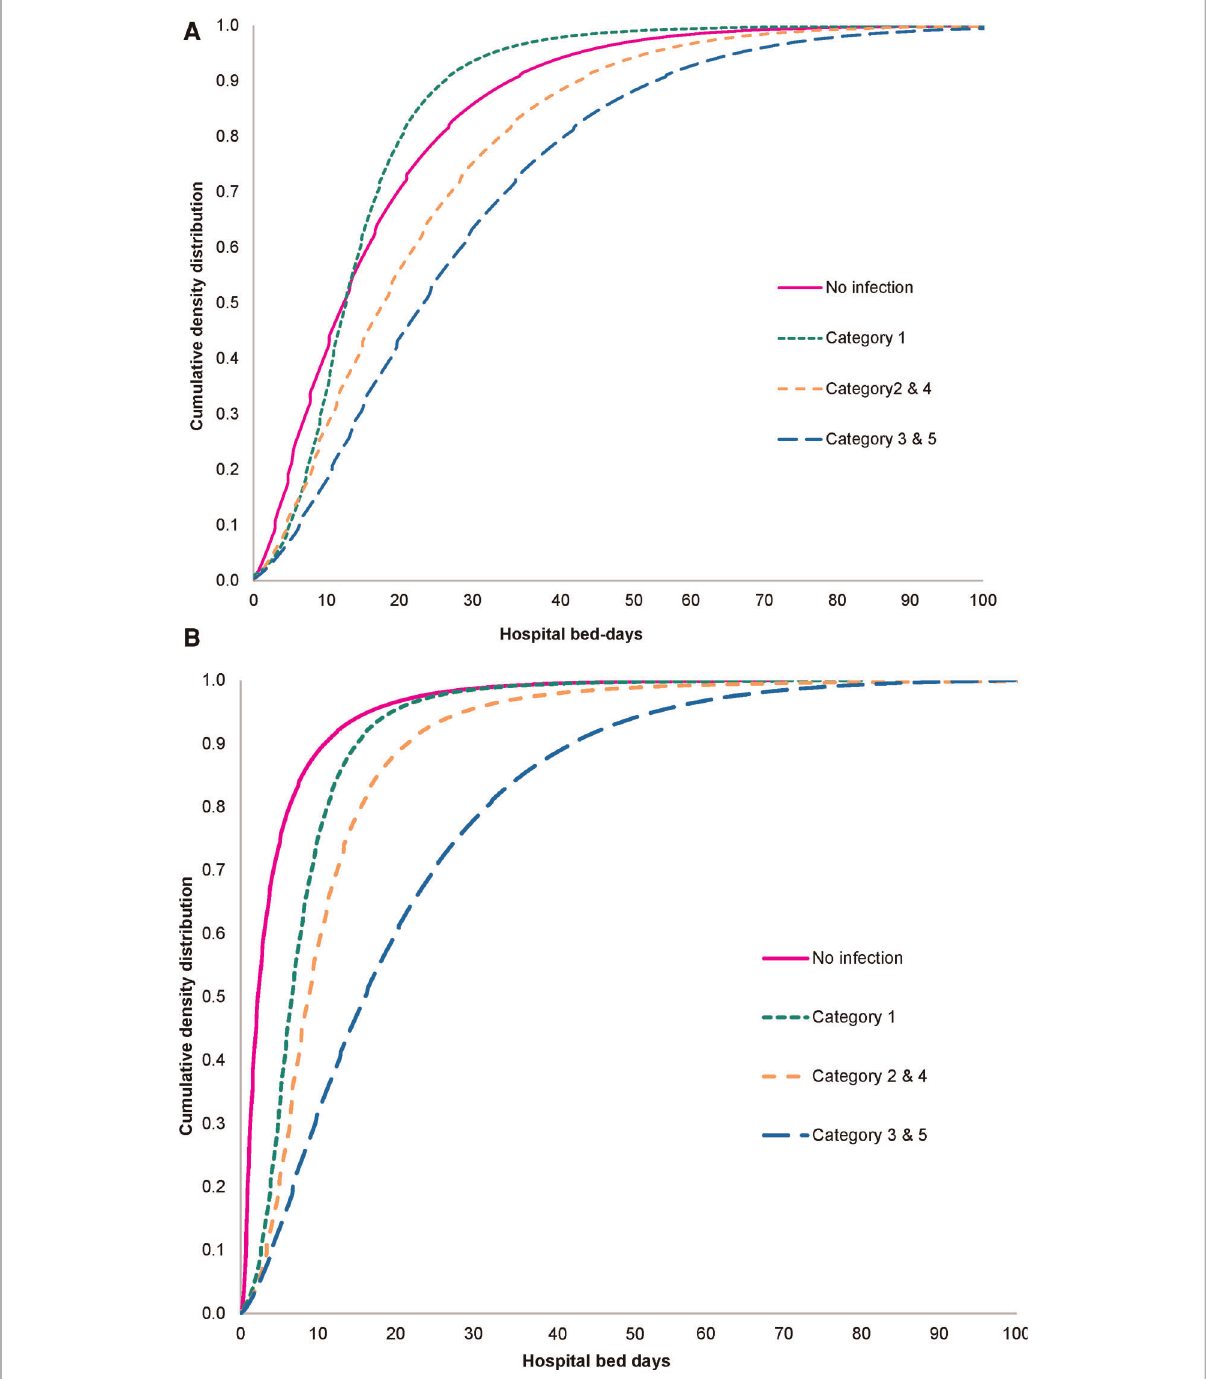
FIGURE 9 ( A ) Slope of hospitalization bed-days for different infection categories in the geriatric ward. ( B ) Slope of hospitalization bed-days for different infection categories in the pulmonology